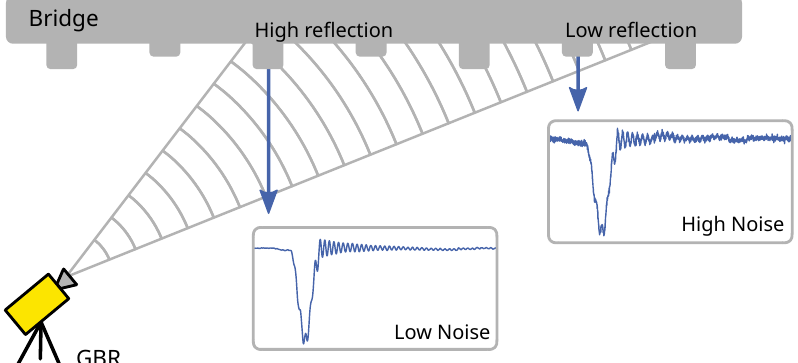
Figure 2. Horizontal view of the measurement principle of GBR of a bridge’s